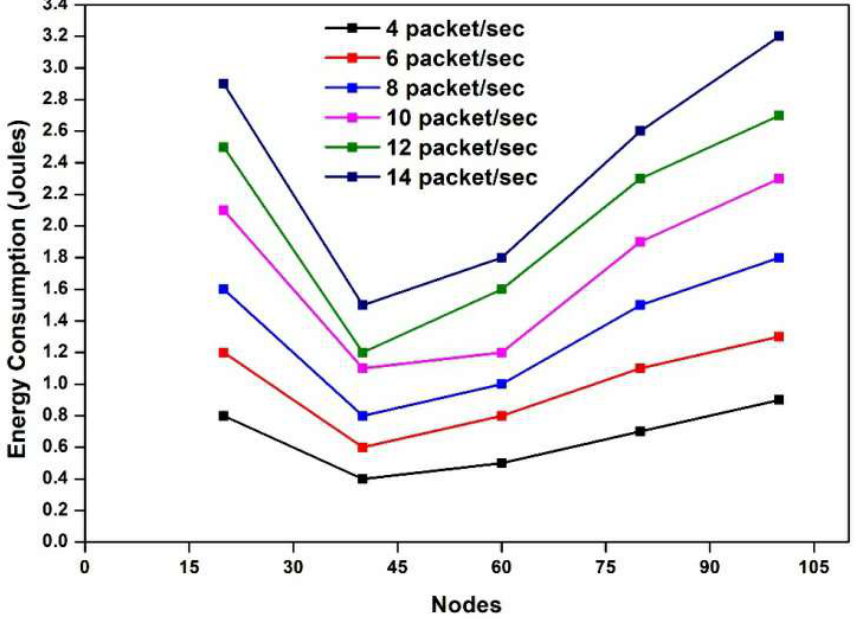
Figure 9. Consumption of energy based on data set.